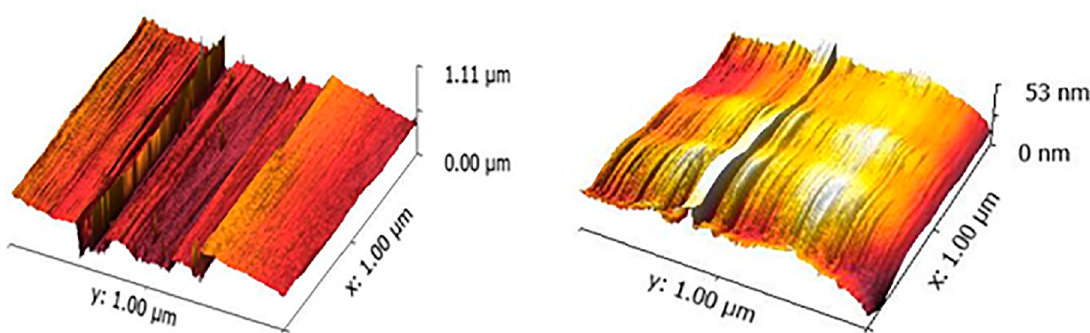
Figure 5. Atomic force microscopy of the PEEK porous (a) and smooth (b) surface,